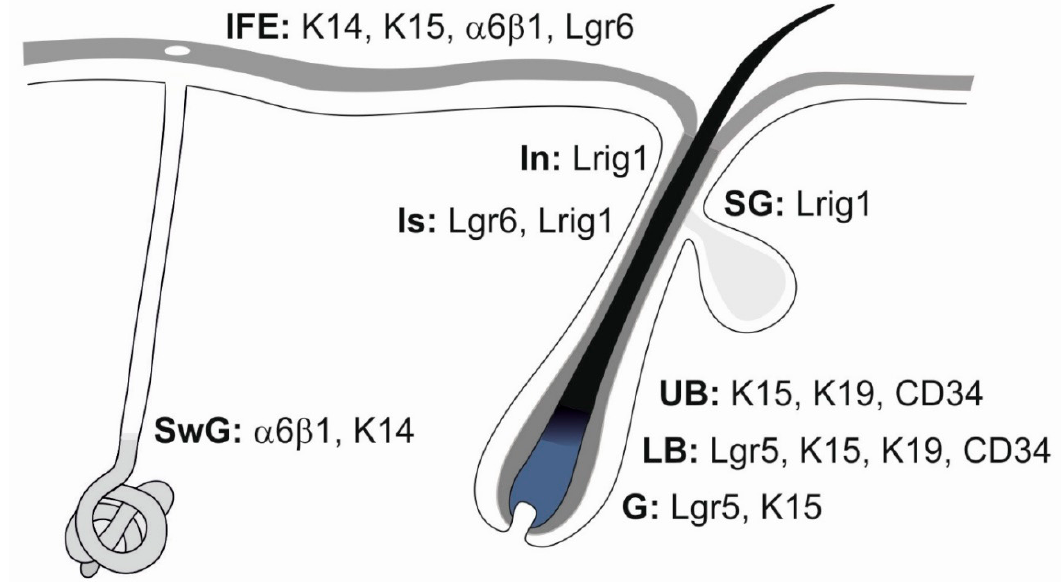
Figure 4. Heterogeneous stem cell populations residing in the epidermis. A schematic drawing represents interfollicular epidermis (IFE), sweat gland (SwG), sebaceous gland (SG), and characteristic morphologic parts of the hair follicle: infundibulum (In), isthmus (Is), upper bulge (UB), lower bulge (LB) and hair germ (G). Distinct stem cell populations can be characterized by specific markers. Modified from [41,43,44].